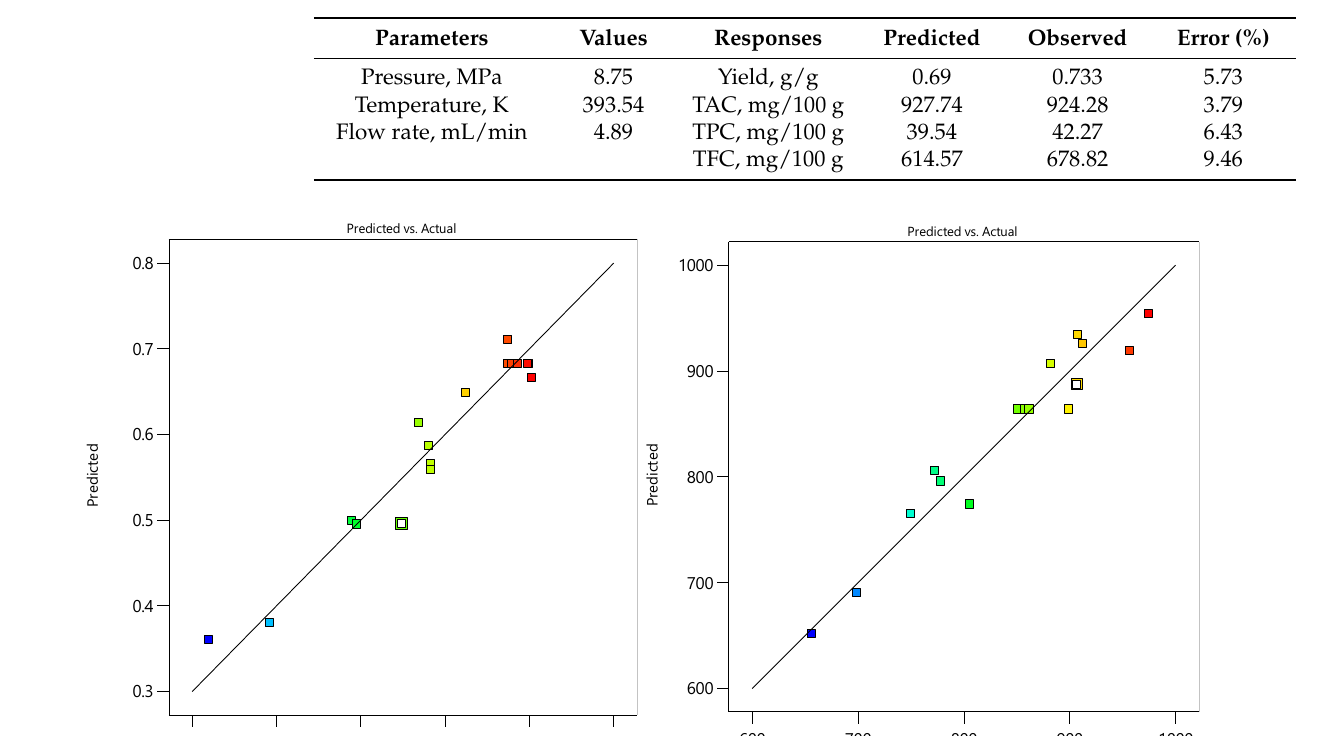
Table 3. The best value of each parameter and response for SWE.